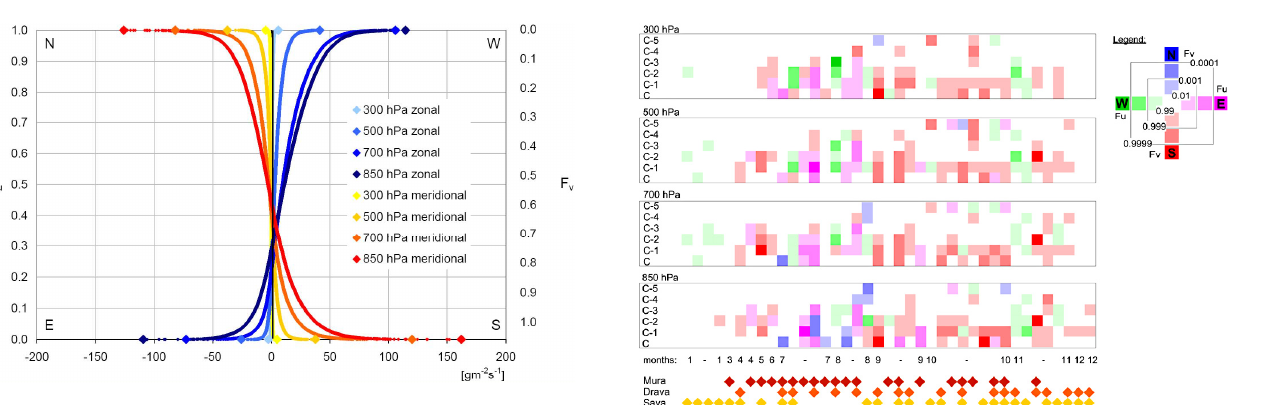
Fig. 4. Extremity of moisture flux during extreme runoff events in the south-eastern Alps. Columns represent 39 individual events arranged according to their annual distribution (respective months are expressed by numbers). Rows in the upper part of the diagram represent the extremity of moisture flux during six days before the river’s culmination (C) at the four isobaric levels using the value of the cumulative distribution function F . The colour marks the mois- ture flux component at one of six studied pixels where the moisture flux was the most abnormal during that respective day ( ∼ the value of F was mostly distant from 0.5). Affected catchments are high- lighted at the bottom of the